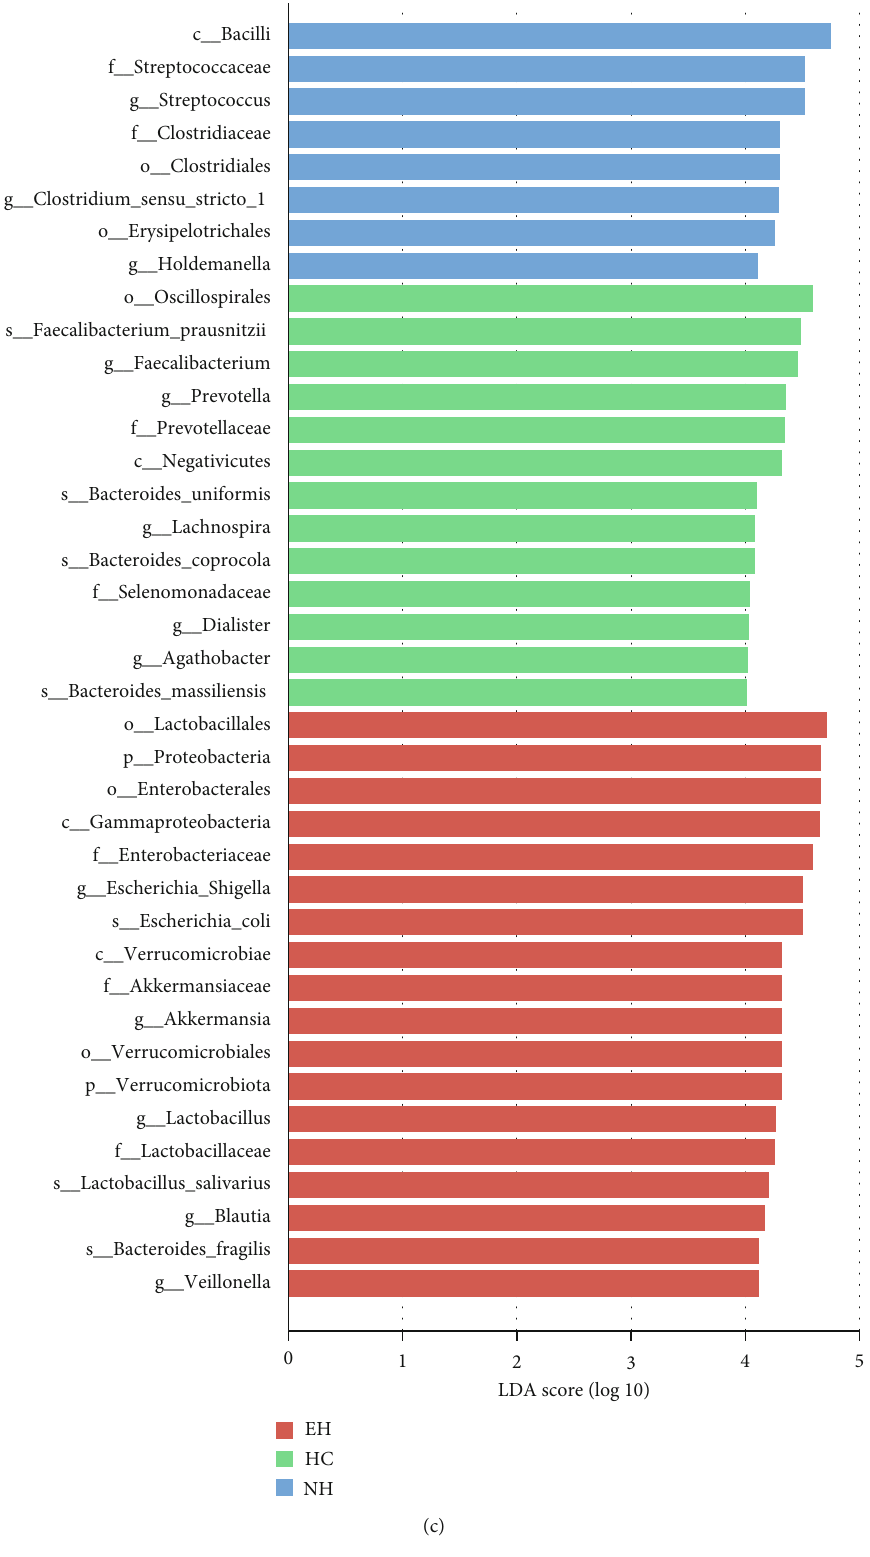
Figure 4: Correlation of intestinal microbiota with clinical indicators. (a) Intestinal microbiota were closely related to multiple clinical indicators. (b) Di ff erential taxa identi fi ed by LEfSe analysis in HC, NG, and EG ( LDA > 4 : 0 ). (c) Di ff erential taxa identi fi ed by LEfSe analysis in HC, NH, and EH ( LDA > 4 : 0 ). HC: healthy controls; NG: normal blood glucose; EG: elevated blood glucose; NH: normal glycosylated hemoglobin; EH: elevated glycosylated